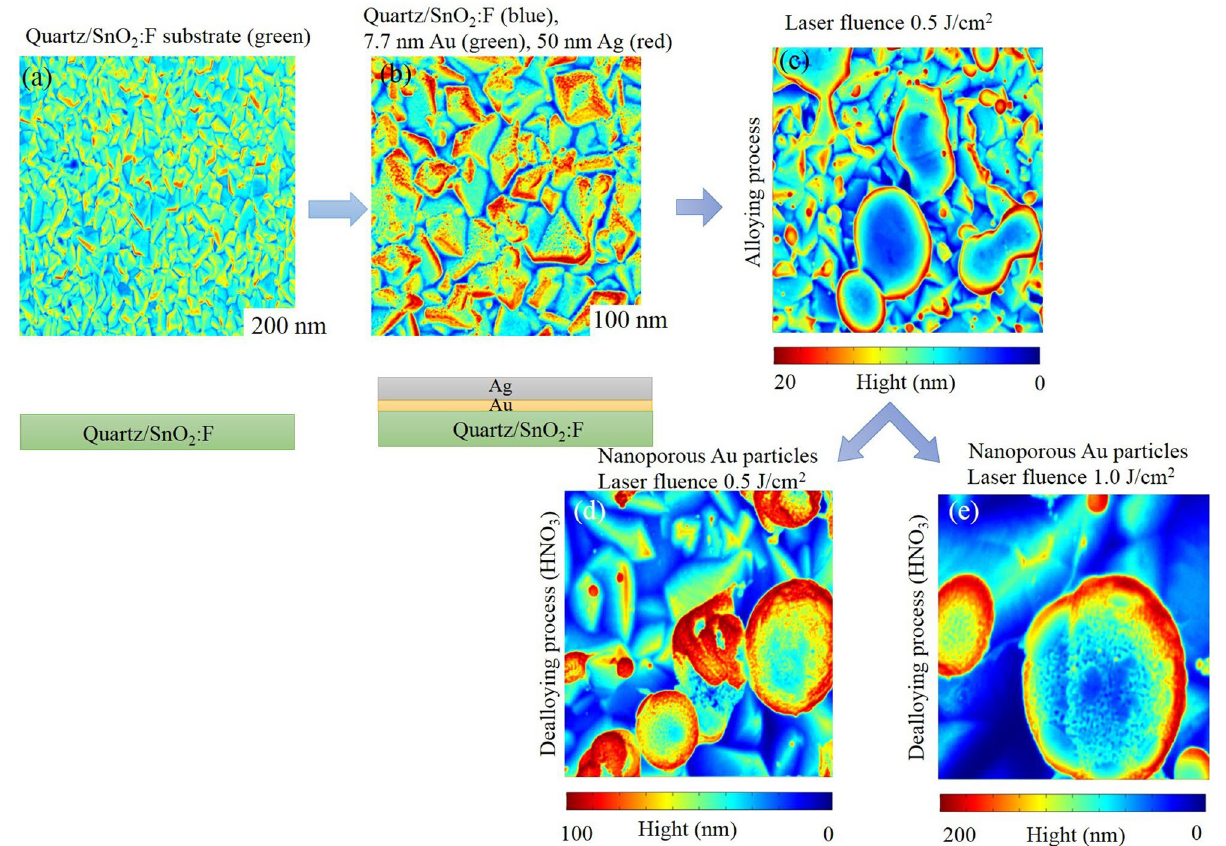
Figure 5. Schematic (top view and section view) of the evolution of the Ag and Au films as a function of the laser fluence. ( a ) quartz/SnO 2 :F substrate ( b ) quartz/SnO 2 :F with 7.7 nm thickness of Au and 50 nm thickness of Ag (untreated bilayer). ( c ) Alloying process of Au/Ag films with laser fluence 0.5 J/cm 2 and 12 ns laser pulse duration. ( d ) Dealloying process of Au/Ag films with laser fluence 0.5 J/cm 2 and 12 ns laser pulse duration. ( e ) Nanoporous Au particles (after HNO 3 etch of Au/Ag alloyed) with laser fluence 1.0 J/cm 2 and 12 ns laser pulse duration.